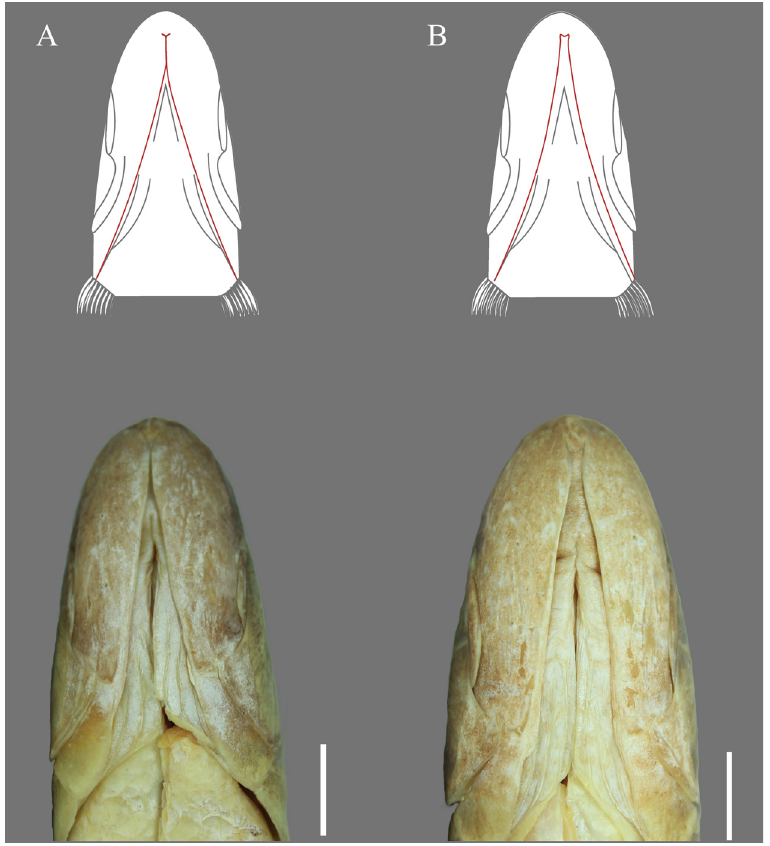
FIGURE 2 | Configuration of the medial margins of the dentary in Hoplias misionera . A. Y-shaped, UFOPA AMTRA126-19, 214 mm SL. B. V-shaped, UFOPA AMTRA127-19, 232 mm SL. Scale bars = 1 cm. Photos by L. R. R. Rodrigues. Illustration by T. M. A. Lima.